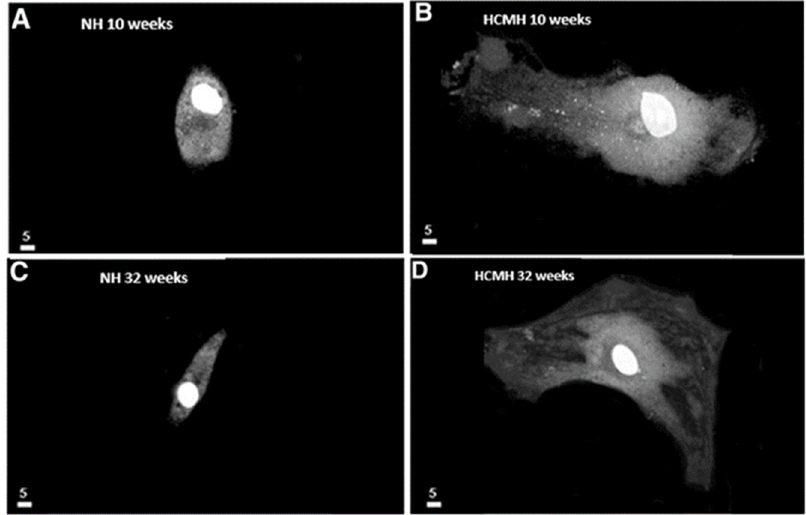
Figure 4. Increase in the volume of endocardial endothelial cells (EECs) in young and old hereditary cardiomyopathic hamsters (HCMHs). ( A – D ) Freshly isolated and cultured EECs from 10-week-old normal hamsters (NH) ( A ), 10-week-old HCMH ( B ), 32-week-old NH ( C ), 32-week-old HCMH, and ( D ) show an increase in the volume (in µm 3 ) of EECs in HCMHs compared to those of age-matched NHs. In panels A–D, the white scale bar is in µm (modified from Jacques and Bkaily 2019) [104].